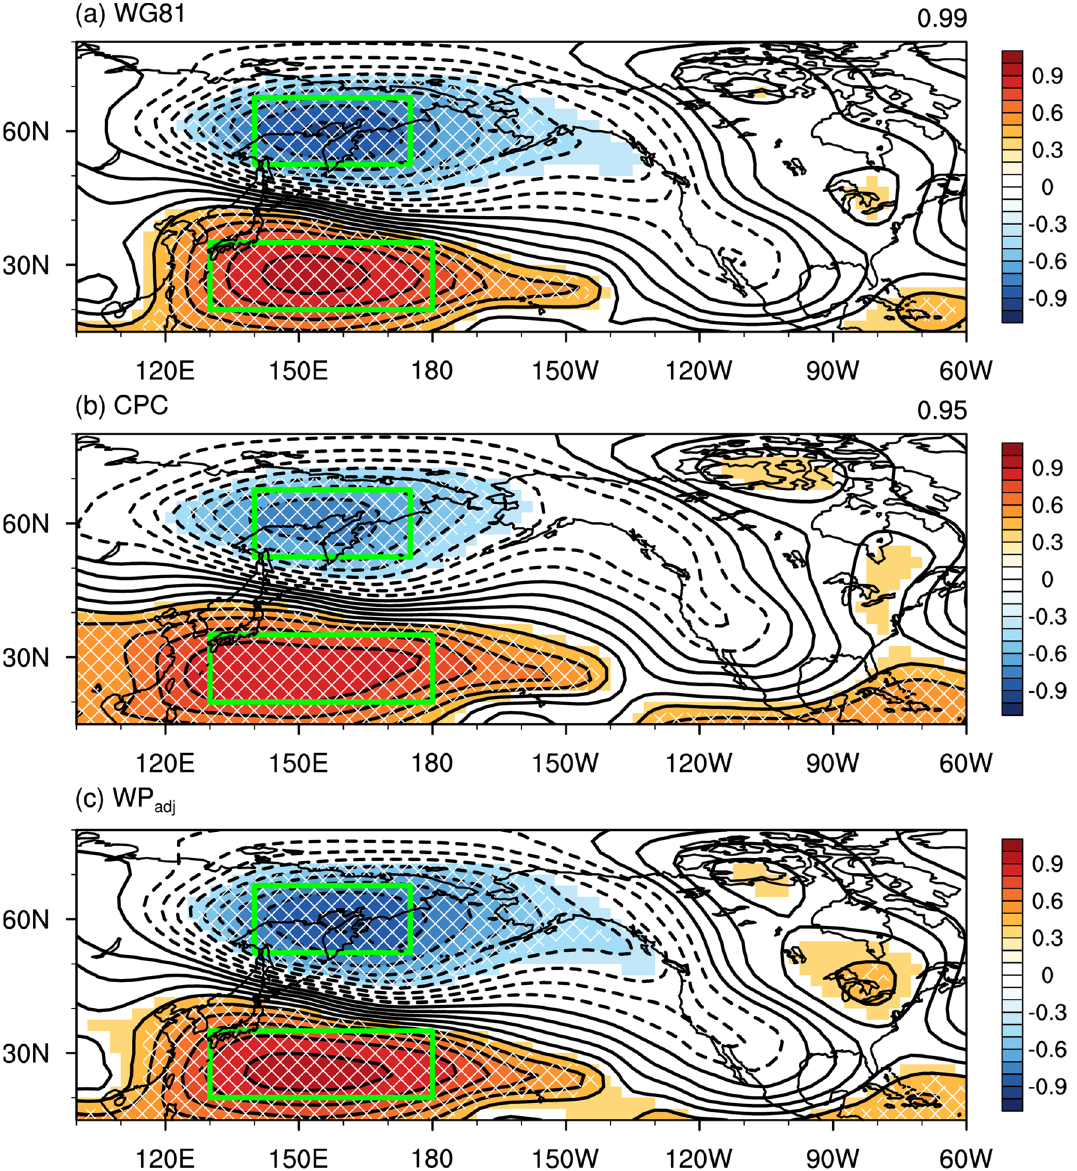
Figure 2. Correlation patterns between Z500 and the WP indices ( a ) WG81, ( b ) CPC, and ( c ) that were used in this study. Green boxes enclose the areas of averaging. The ACC between the WP index used in the study and the WG81 WP and CPC WP patterns are shown in the top-right corner of the panels. Significant at the 99% (95%) confidence level values are shown by hatch pattern (shading).